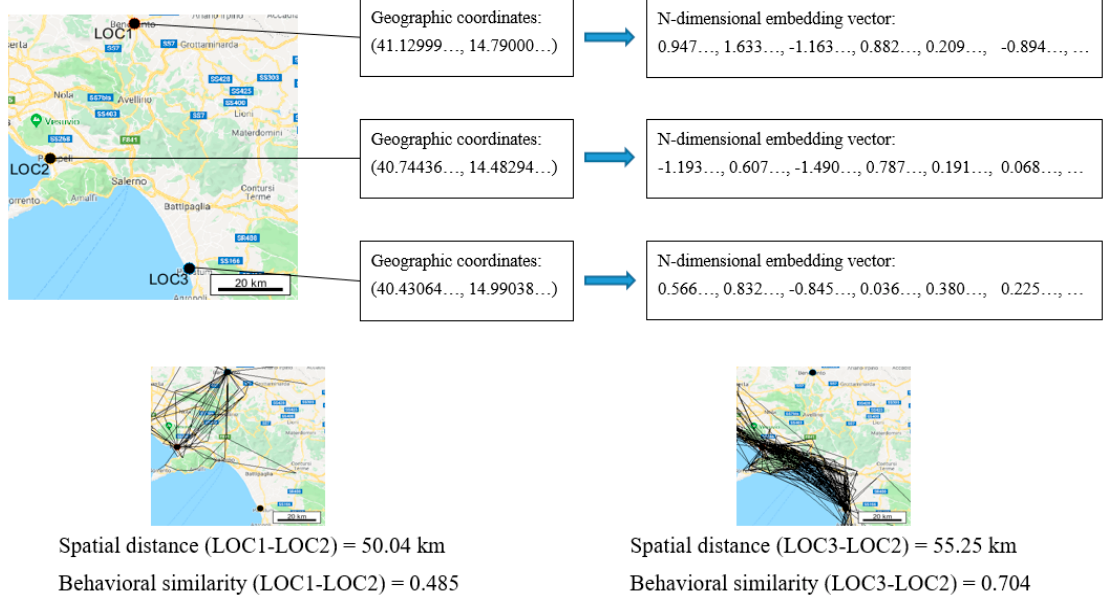
Figure 6. Geographic representation and embedding representation of LOC1, LOC2 and LOC3 of the example of Figure 1. Although spatial distance LOC1–LOC2 is slightly shorter, LOC3 and LOC2 are substantially more similar.